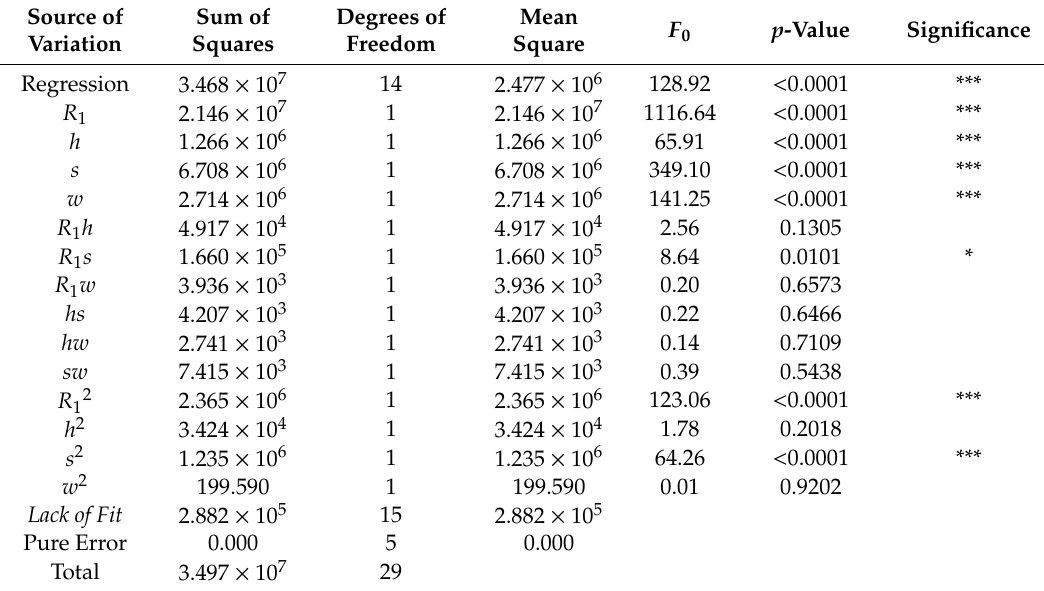
Table 8. Analysis of variance.